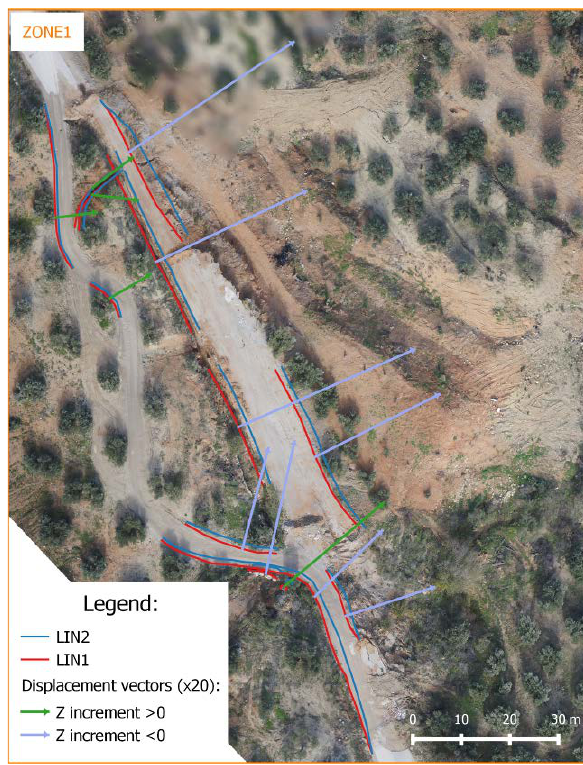
Figure 5. Displacement vectors (20x) from VIM-I in ZONE1.